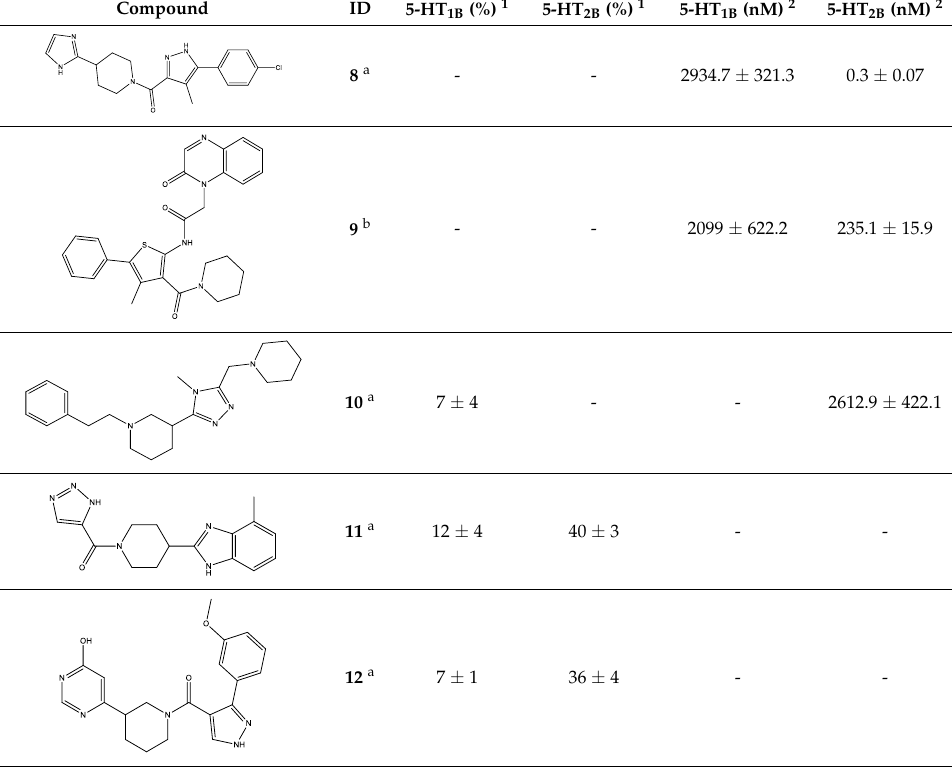
Table 2. Structures and measured in vitro assay data of top-ranked compounds (sorted by percentage of inhibition and K i (nM) in h5-HT 2B R competition binding assay). Values represent the mean ± SD of three independent assays with duplicate measurements.